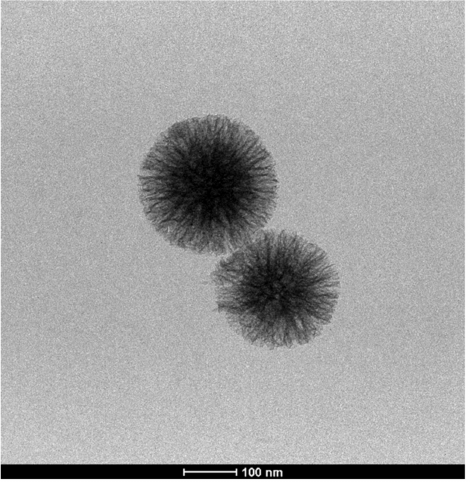
Figure 7. TEM micrograph of wrinkled silica